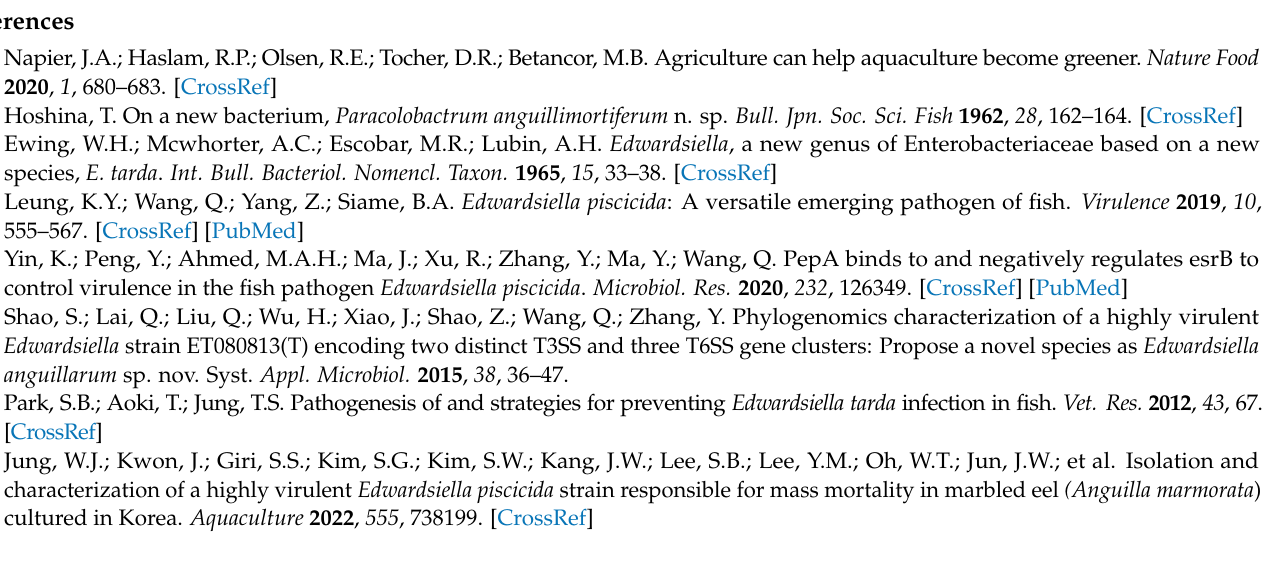
Table S2: Oligonucleotide primers used in this